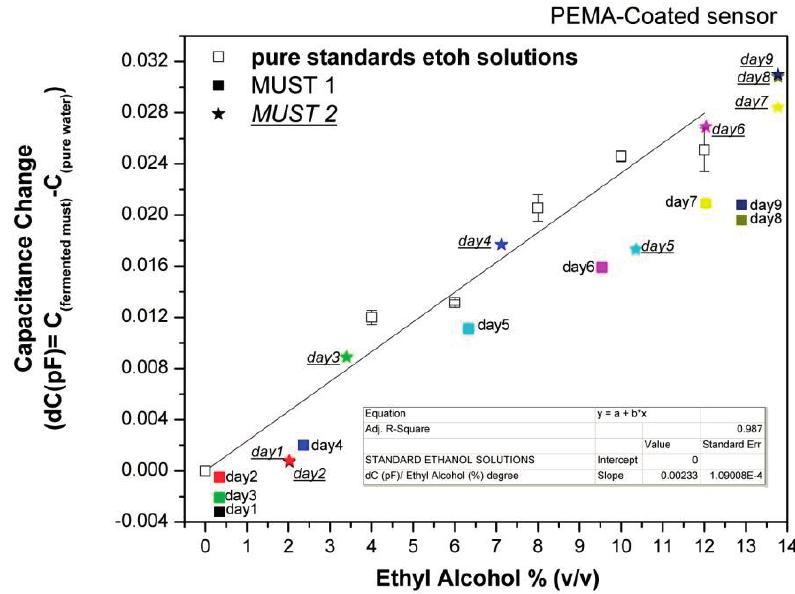
Figure 7. Equilibrium responses of a relative hydrophobic polymer-coated sensor upon exposure to the headspace of pure ethanol solutions in comparison with data of fermentations.